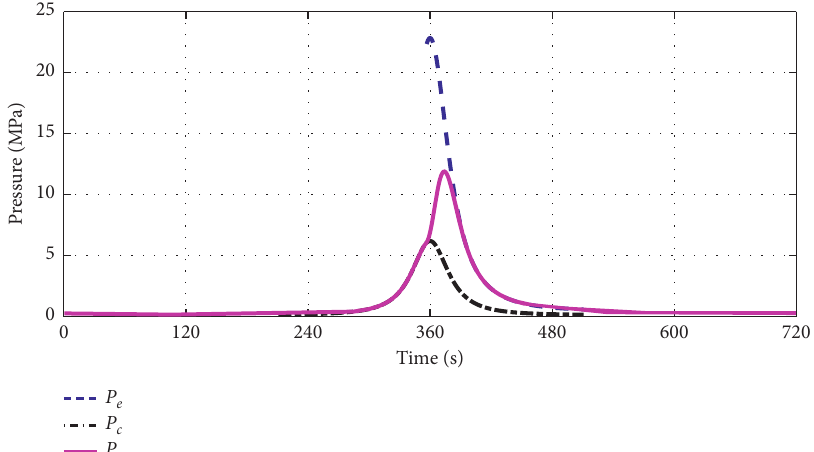
Figure 3: The trajectories of P